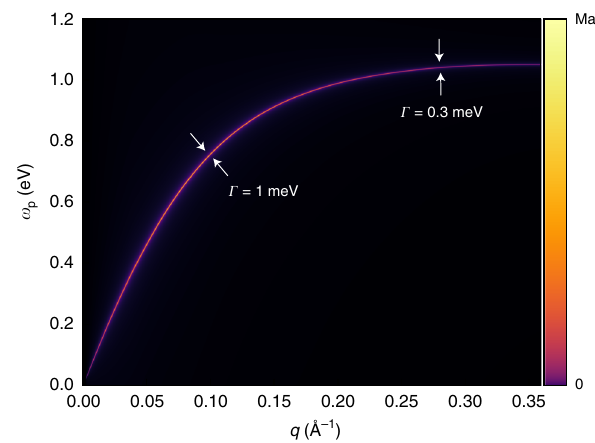
Fig. 4 Plasmon spectral function with amplitude given in color scale for an intrinsic monolayer of TaS 2 computed from fi rst principles. We consider only decay processes solely from phonon-assisted scatterings, since the plasmon is outside of the Landau damping regions for the plotted range of wavevectors. The plasmon linewidth Γ becomes slightly sharper for modes with higher frequencies due to the smaller density of fi nal states that the plasmon can decay to (see Methods section). The intrinsic plasmon linewidth decreases from 1 meV at ~0.15 Å (cid:5) 1 down to 0.3 meV at q ~ 0.3 Å (cid:5) 1